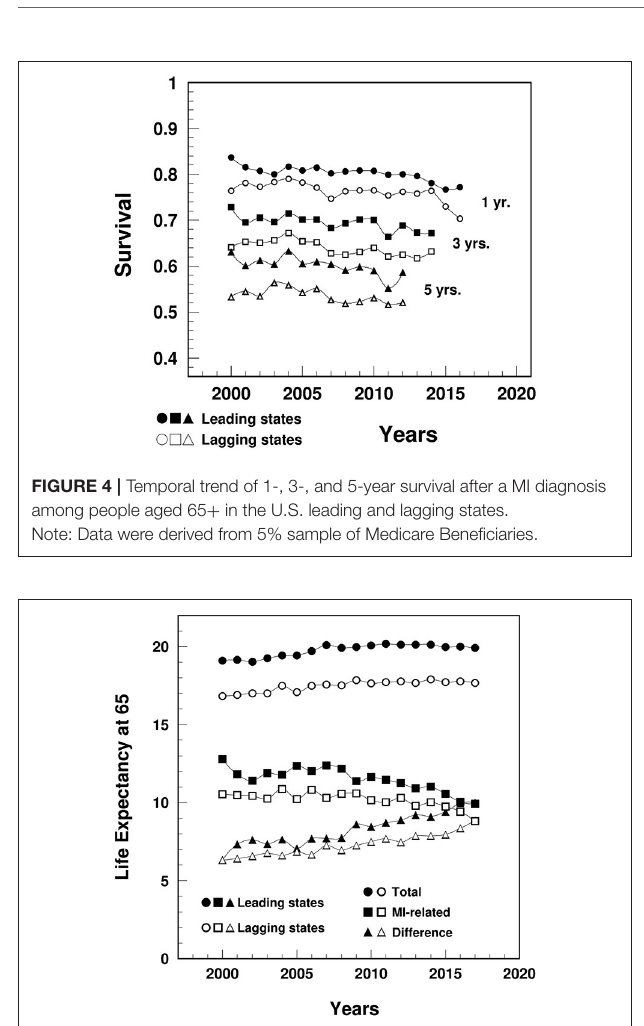
FIGURE 5 | Temporal trend of remaining life expectancy at age 65 (years) among MI patients and non-MI patients and their gap in the leading and lagging states. Note: Data were derived from 5% sample of Medicare